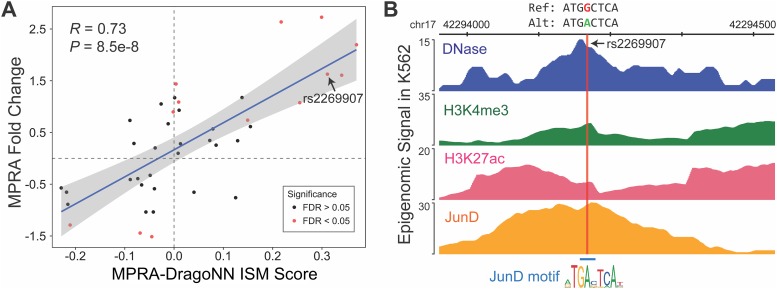
Variant in-silico mutagenesis scores agree with experimental data.(A) Regulatory activity changes between reference and mutated sequences predicted by MPRA-DragoNN agree with experimentally measured changes [36]. Red points indicate variants that were significant in the wild-type K562 condition (see description in Methods) (B) Detailed examination of a particular variant, rs2269907 at chromosome 17 position 44,294,214. The distribution of epigenetic marks and JunD ChIP-seq signal [2] around the variant reveals that it lies in an active region [51]; the variant appears to correct a mismatch in one of the base pairs of a JunD motif, allowing JunD to bind and regulate expression.